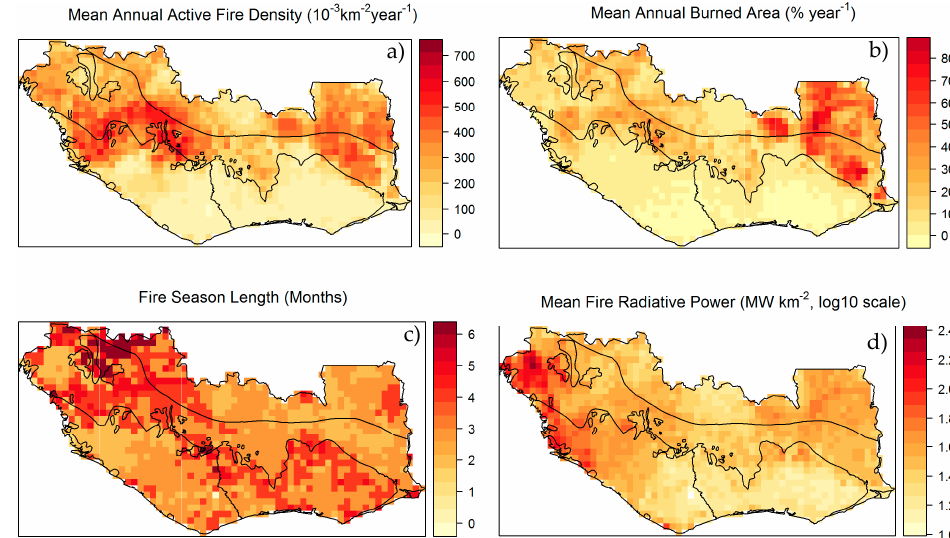
Figure 2. Maps of four major fire regime components, which were the response variables in the BRT models: ( a ) active fire density; ( b ) percent burned area; ( c ) fire season length; ( d ) fire radiative power.